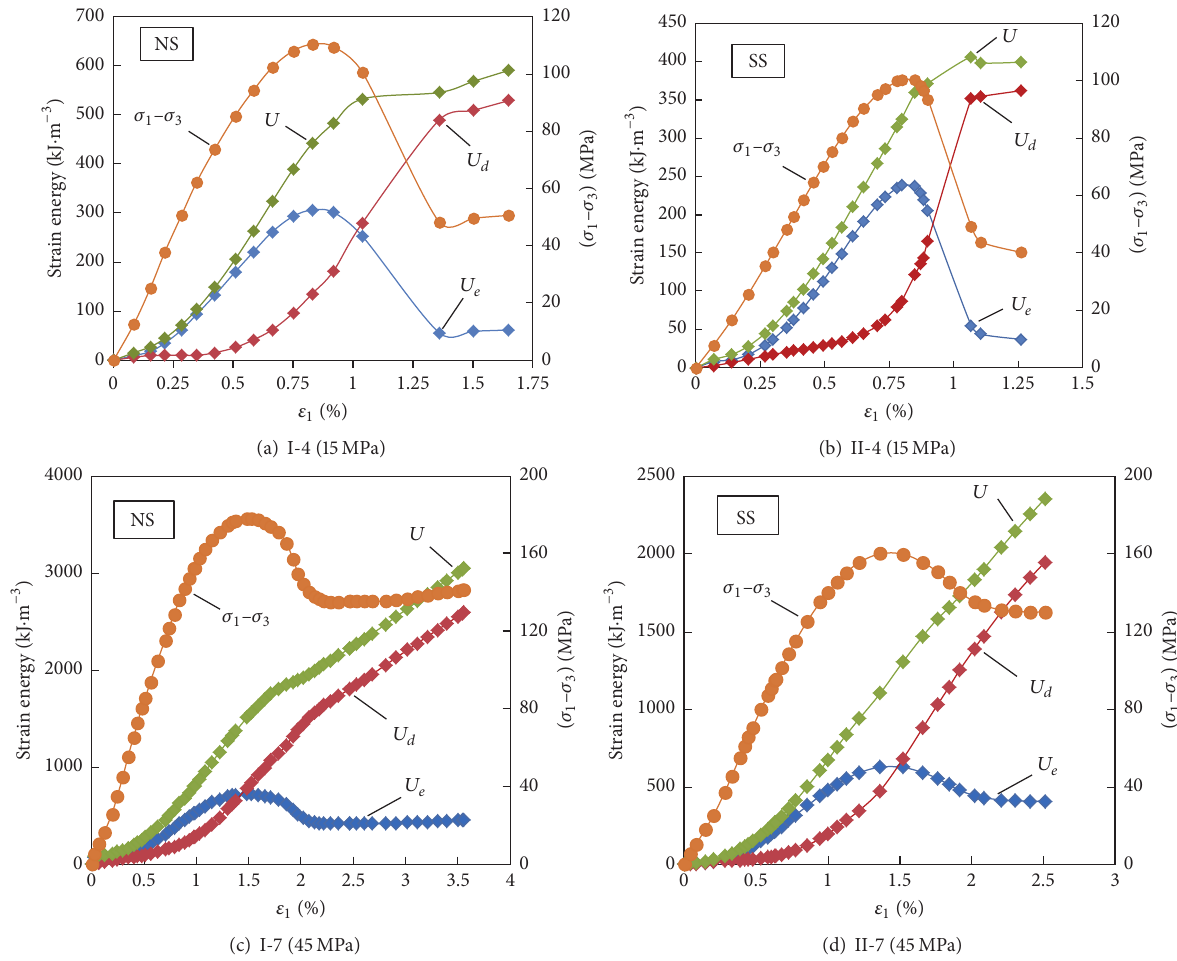
Figure 9: The energy conversion curves of triaxial compression